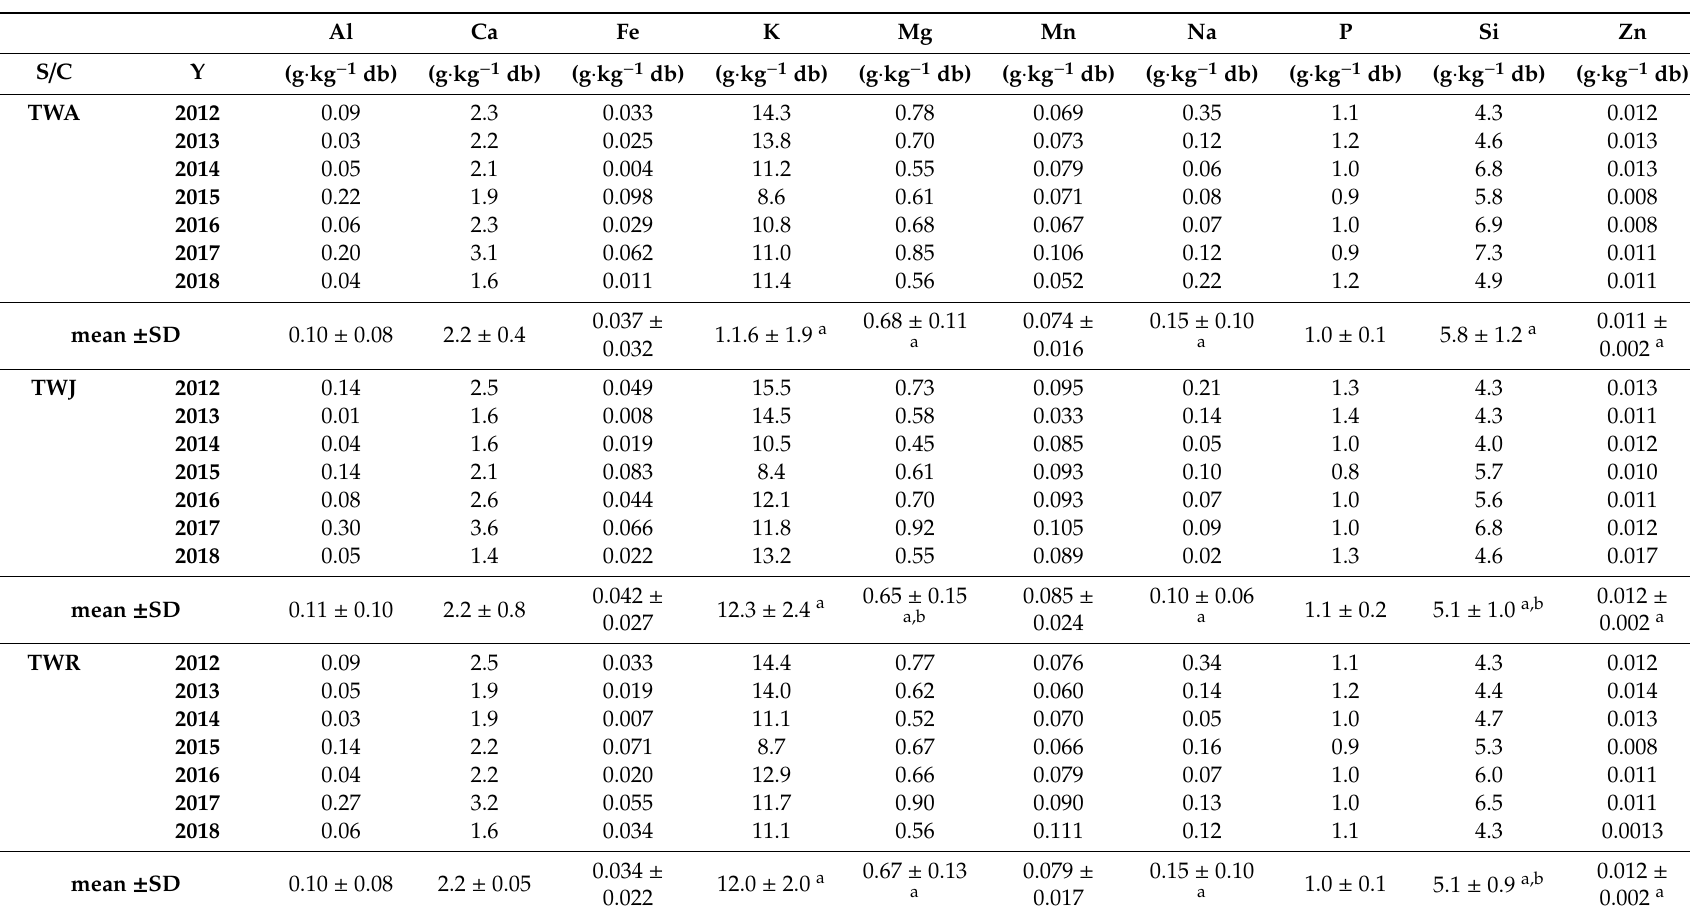
Table 7. Major elements present in the biomass of di ff erent grasses collected at CS plots between 2012 and 2018. Mean values for three replicate plots per species and